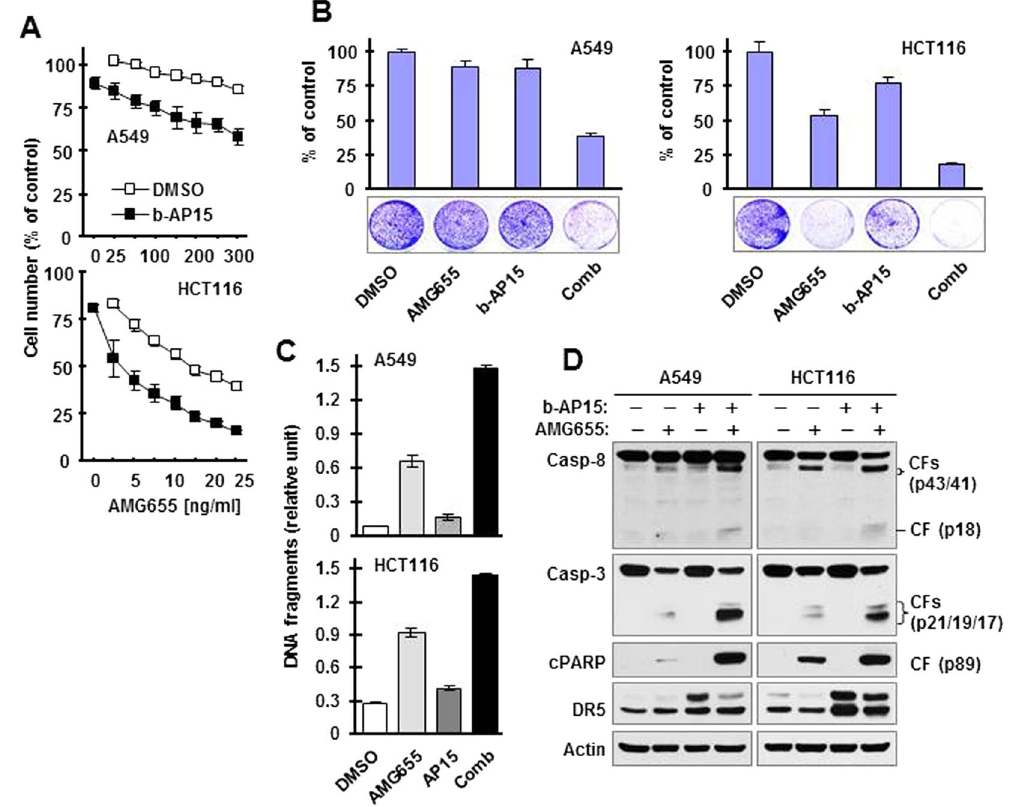
Figure 4. b-AP15 enhances the effects of AMG655 in decreasing cell survival ( A and B ) and inducing apoptosis ( C and D ) in cancer cells. ( A ) Different cancer cell lines in 96-well plates were exposed to DMSO or 0.5 μ M b-AP15 for 3 h followed by co-treatment with varied concentrations of AMG655 for an additional 24 h. Cell numbers were the estimated with the SRB assay. The data are means ± SDs of four replicate determinations. ( B ) The given cell lines in 12-well plates were pre-treated with DMSO or 0.1 μ M b-AP15 for 4 h and then co- treated with 100 ng/ml (A549) or 10 ng/ml (HCT116) AMG655 for an additional 60 h. The cells were then stained with crystal violet dye. The data are means ± SDs of triplicate determinations. ( C ) and ( D ) The indicated cell lines were exposed to 0.5 μ M b-AP15 for 3 h followed by co-treatment with 100 ng/ml (A549) or 10 ng/ml (HCT116) AMG655 for an additional 4 h. The cells were then harvested to measure DNA fragments with a cell death detection ELISA kit ( C ) and to detect the cleavage of caspases and PARP ( D ). The data are means ± SDs of triplicate determinations. CF, cleaved fragment. Full-length blots/gels are presented in Supplementary Figure